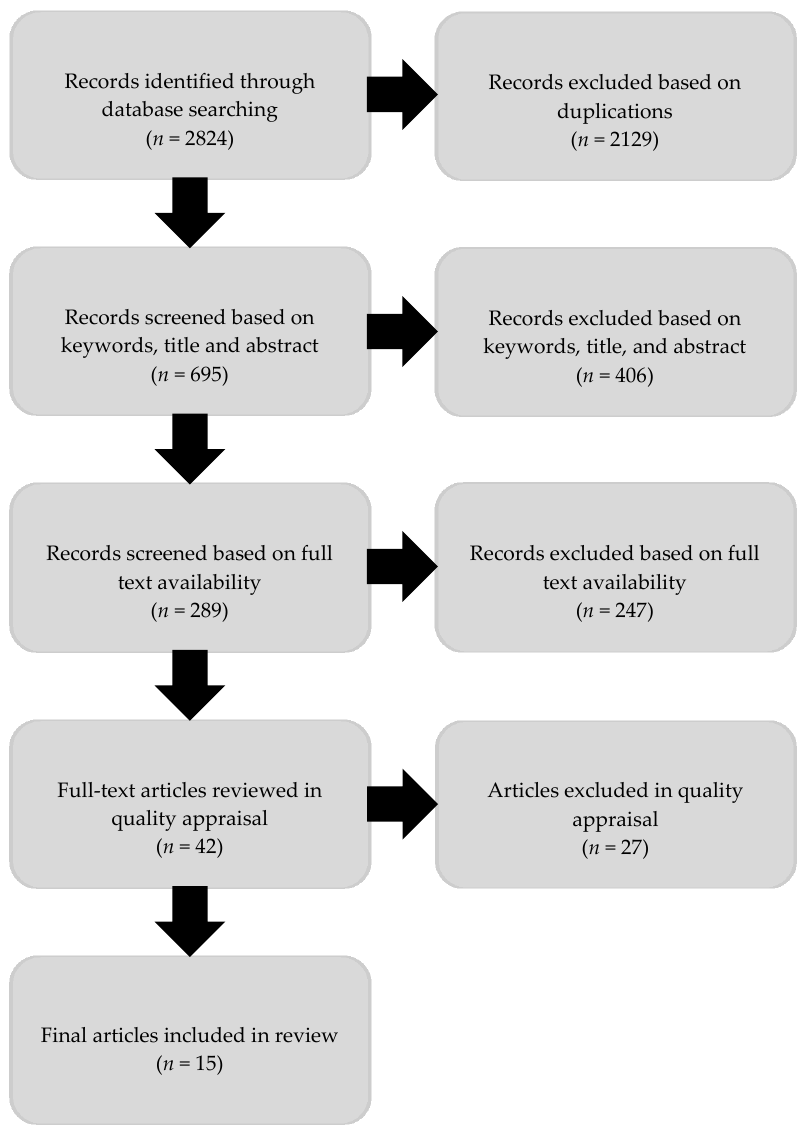
Figure 1. Flow diagram of review process.